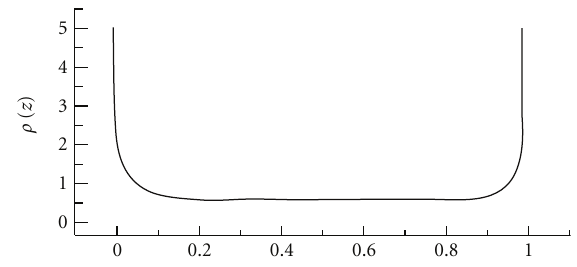
Figure 2: Probability density function of chaotic sequence of logistic map.